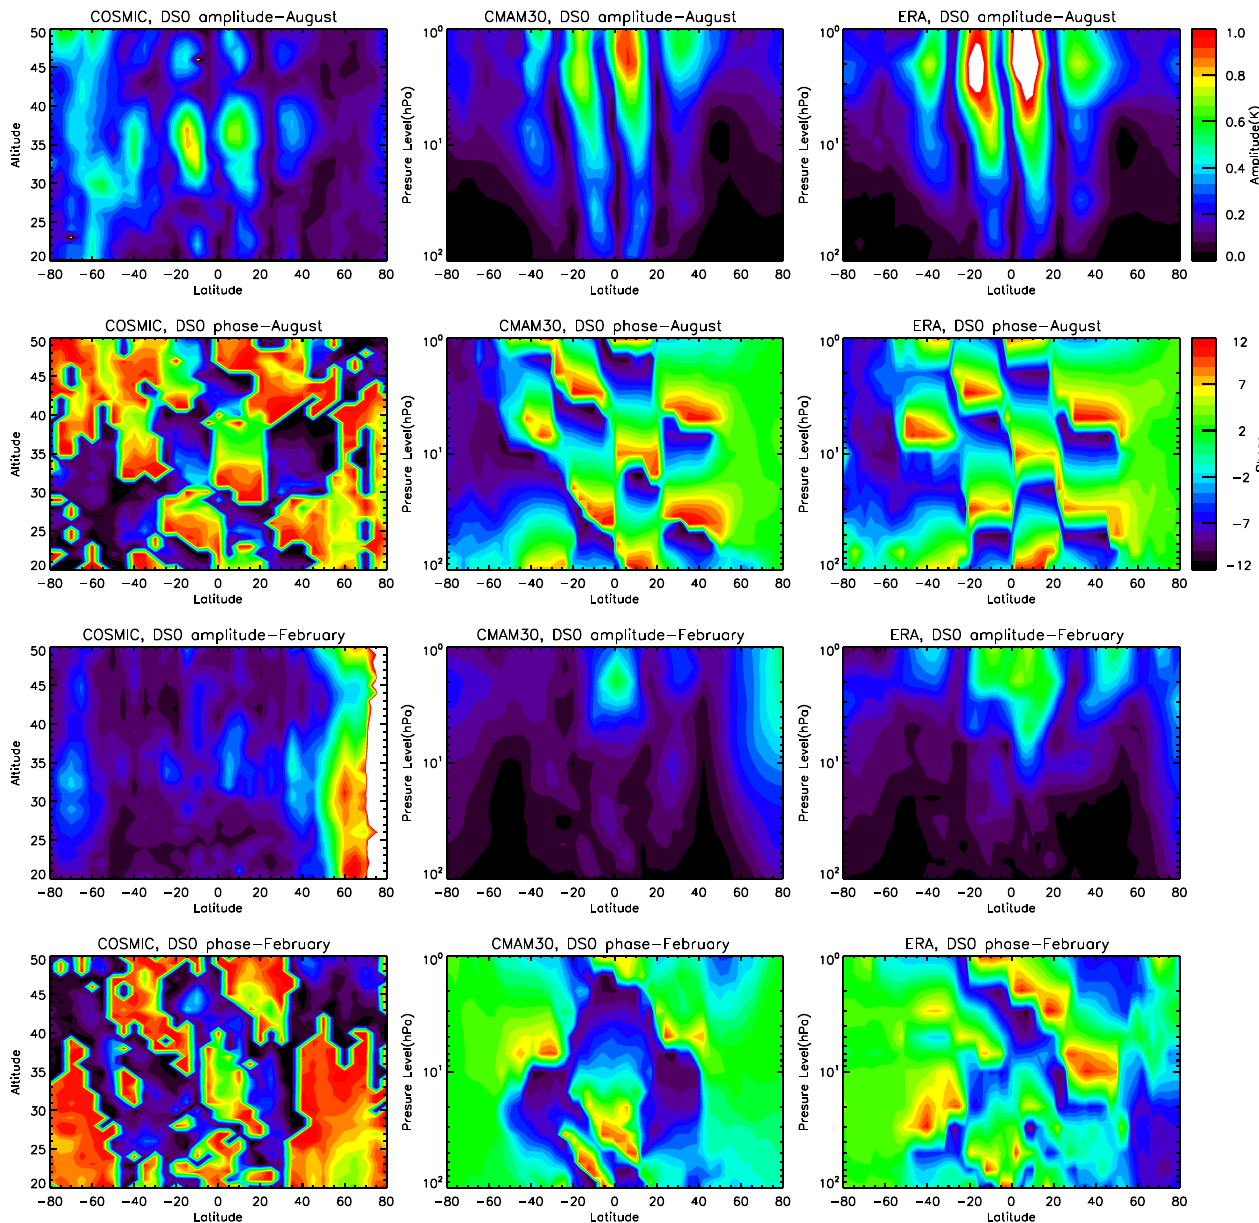
Figure 5. Altitude versus latitude cross-section of mean amplitude and phase of DS0 tide during August 2008 and February 2009 from COSMIC, CMAM30, and ERA-interim